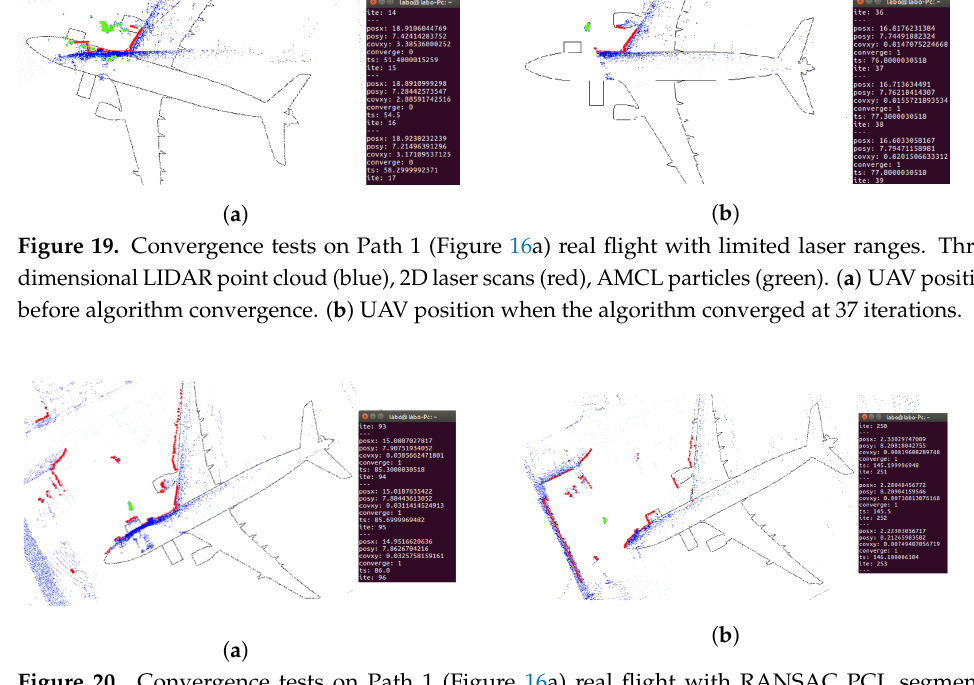
Figure 20. Convergence tests on Path 1 (Figure 16a) real flight with RANSAC PCL segmenta- tion. Three-dimensional LIDAR point cloud (blue), 2D laser scans (red), AMCL particles (green). ( a ) UAV position before algorithm convergence. ( b ) UAV position when the algorithm converges after 250